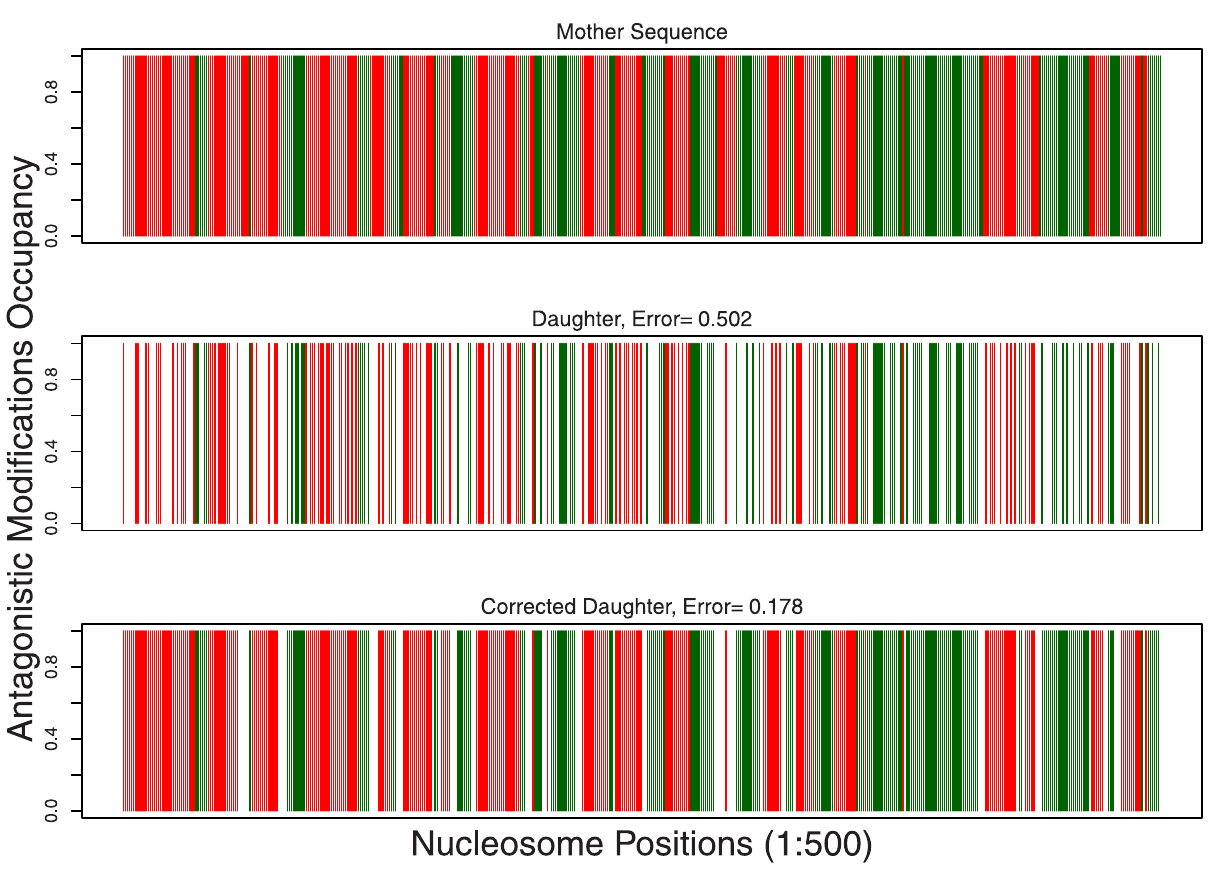
Fig 6. Simulating antagonistic modifications: Typical realizations of the modification patterns from the study of two spatially distinct/ antagonistic modifications, spread over 500 nucleosomes. The red and green regions represent the modifications 1 and 2, respectively, and the white regions represent absence of both modifications (value 0). Corrections were performed using the threshold- k algorithm with an optimum k